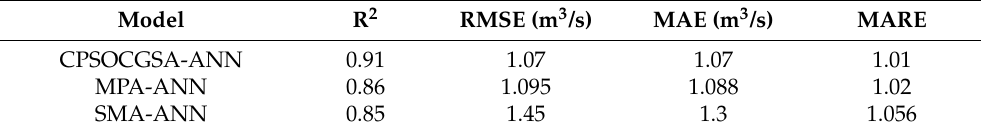
Table 2. The performance of CPSOCGSA-ANN, MPA-ANN, and SMA-ANN in the validation stage.